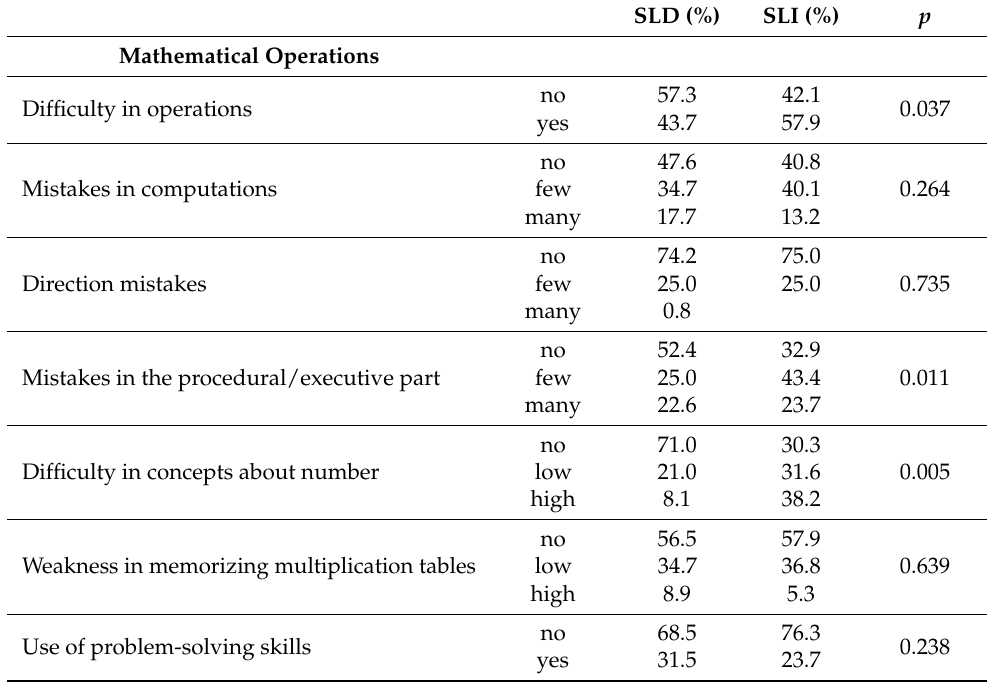
Table 5. Results for mathematical operations and reasoning with respect to